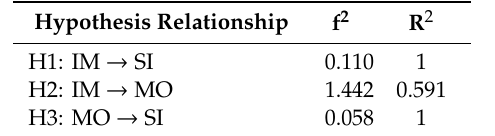
Table 7. Assessment of Co-e ffi cient of Determination R 2 and E ff ect size f 2